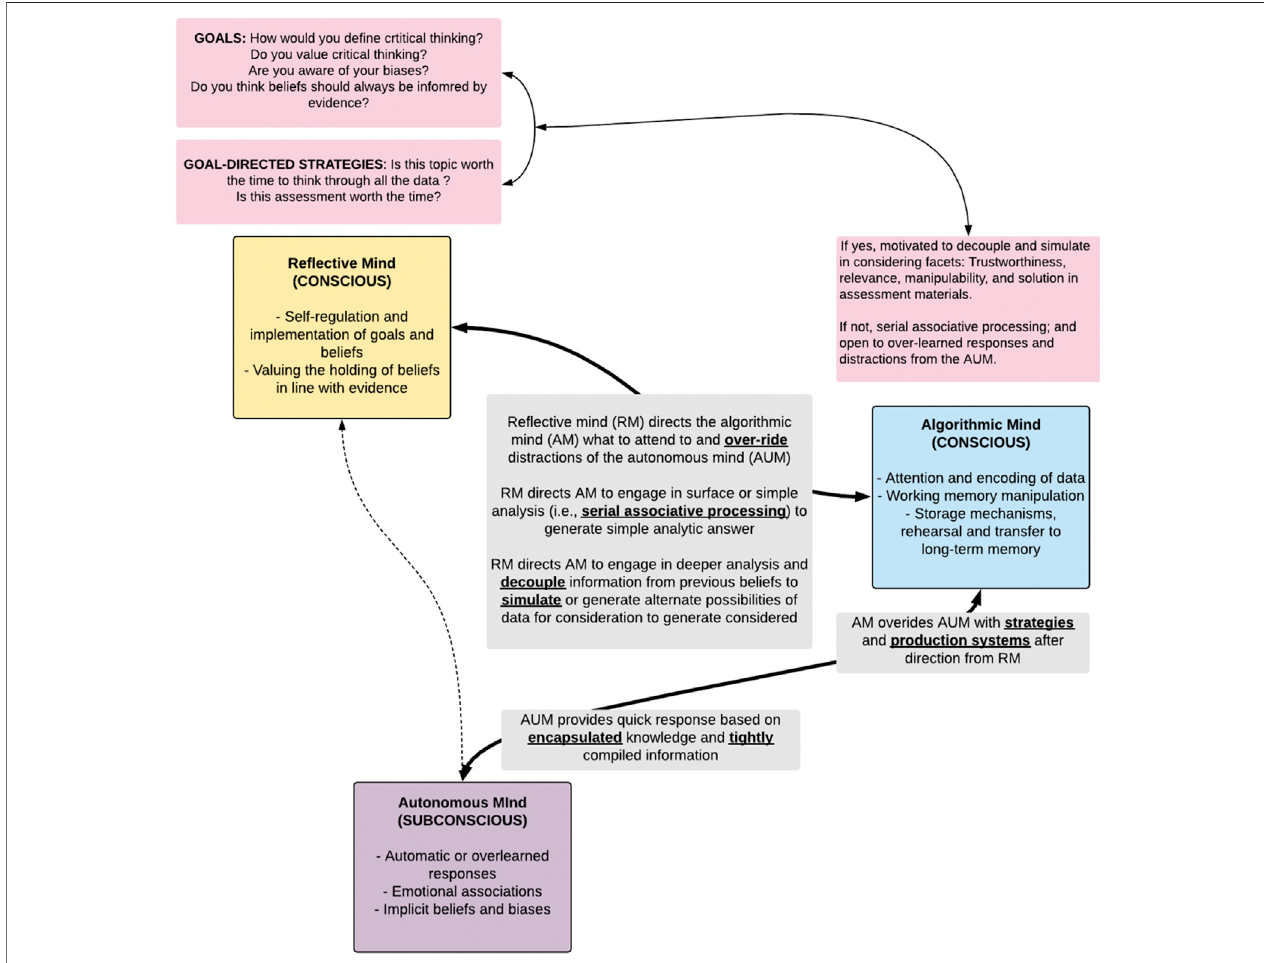
FIGURE 4 | Re fi ning the connections among three different aspects or minds (Stanovich and Stanovich, 2010) integral to engaging facets of critical thinking on performance assessments (Shavelson et al., 2019) in data-rich environments.